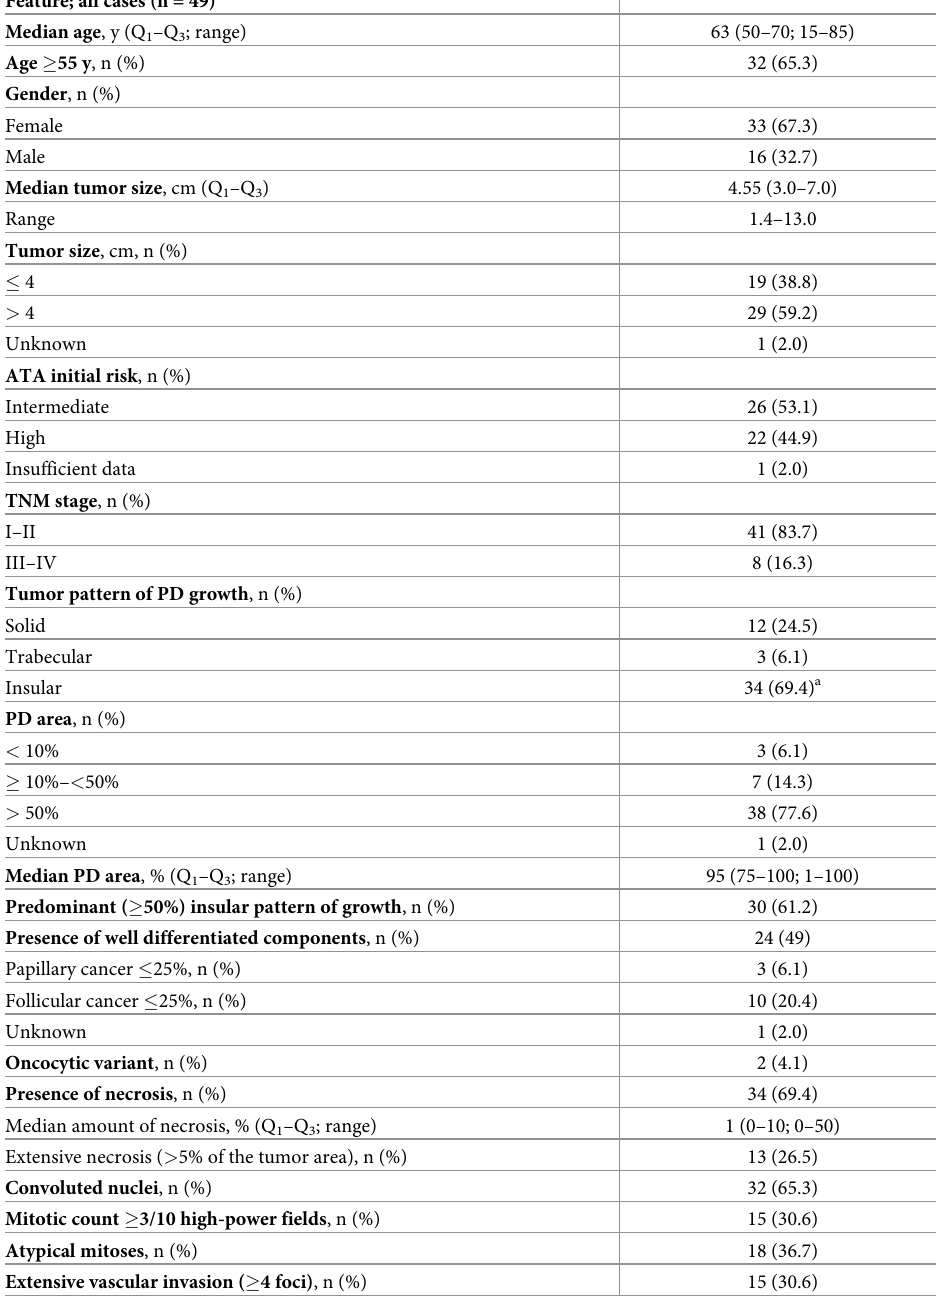
Table 1. Clinical and pathological characteristics of the 49 patients with poorly differentiated thyroid cancer at the presentation